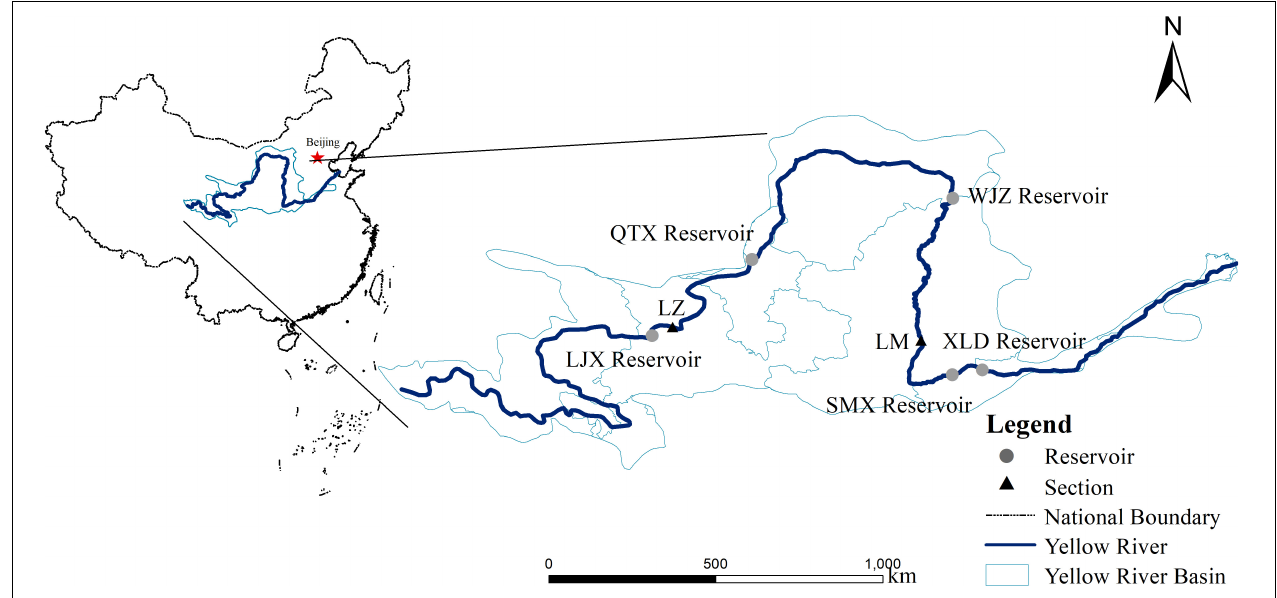
FIGURE 1 | The main stations of the Yellow River Basin (YRB). LZ, Lanzhou; LM, Longmen; H LJX reservoir, Liujiaxia reservoir; QTX reservoir, Qingtongxia reservoir; WJZ reservoir, Wanjiazhai reservoir; SMX reservoir, Sanmenxia reservoir; XLD reservoir, Xiaolangdi